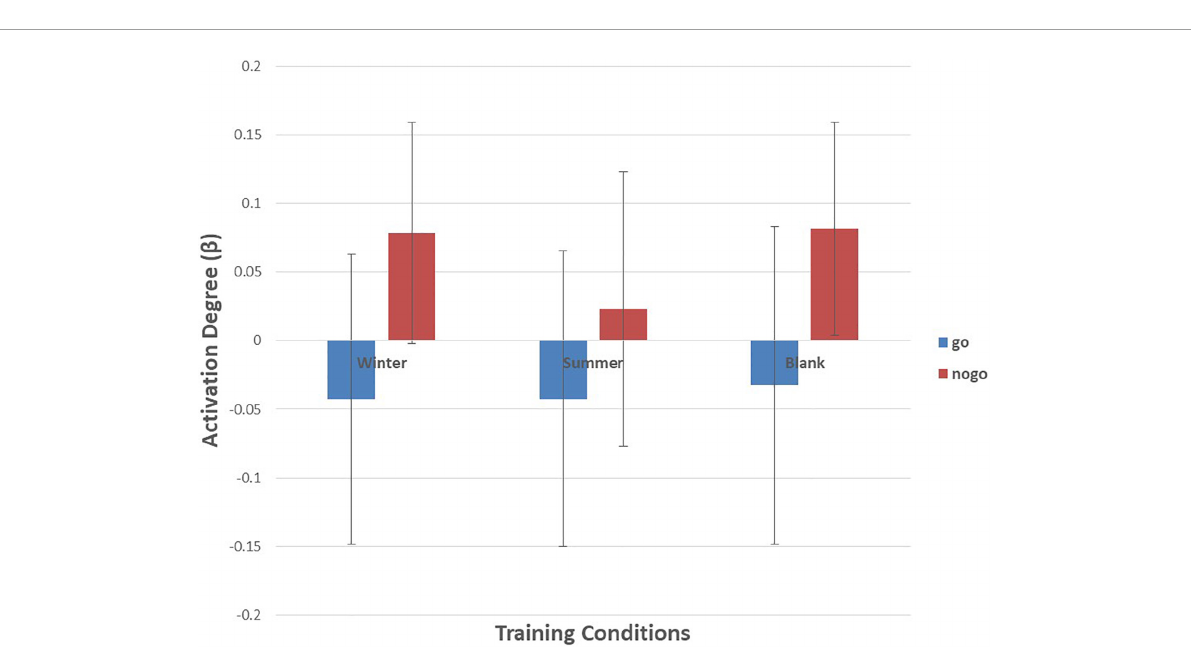
FIGURE7 Means of activation degree ( β ) of ch7 of go tasks and nogo tasks in three training conditions. Error bars represent the standard